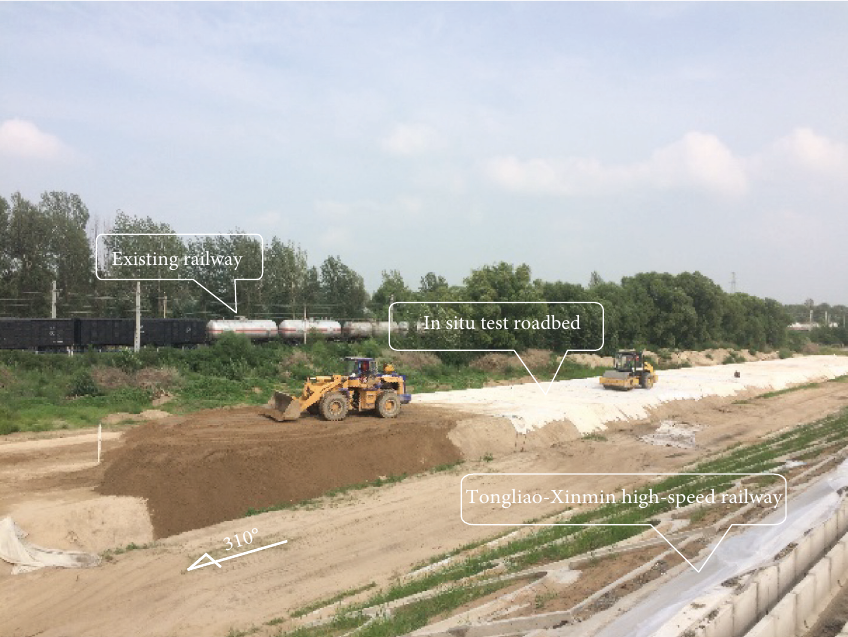
Figure 2: Spatial relationship diagram of the test roadbed and the railway under